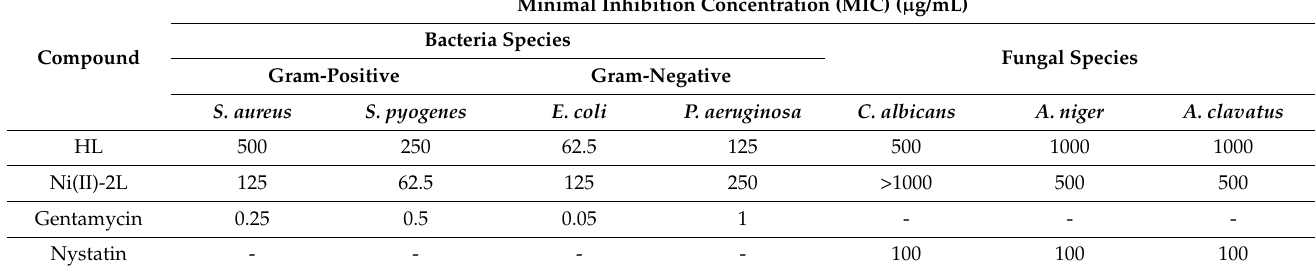
Antimicrobial activities of the N (cid:48) -(4-methoxybenzylidene)benzohydrazide (HL) ligand and its nickel complex